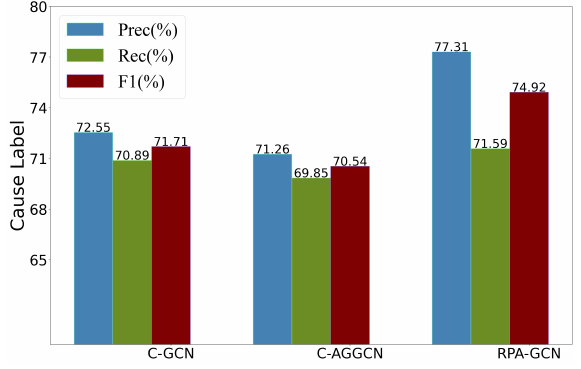
Figure 11. Value of precision, recall, and F1 of cause tags.